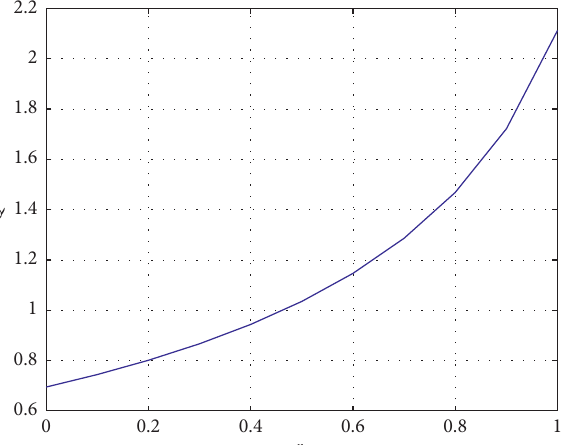
Figure 10: Effect of unit residual value r supply chain.